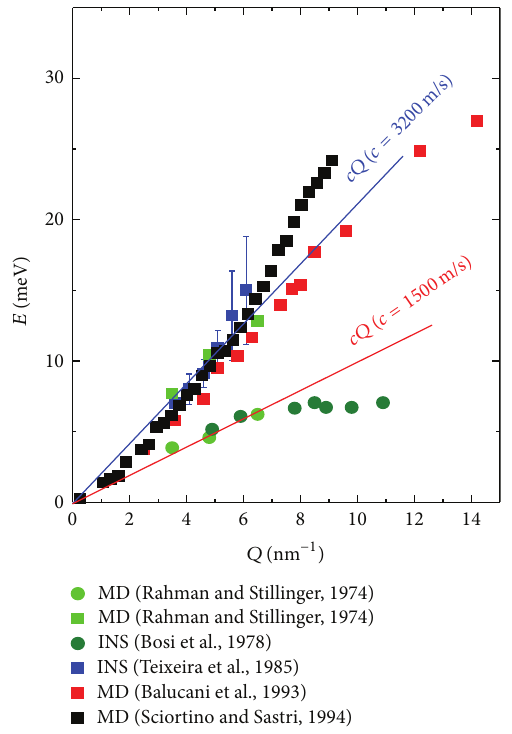
Figure 4: The sound dispersion curves of water as determined before the advent of IXS by the experimental and computational methods indicated in the legend. The two linear laws corresponding to the hydrodynamic and “fast sound” dispersions are reported for reference as red and blue straight lines,